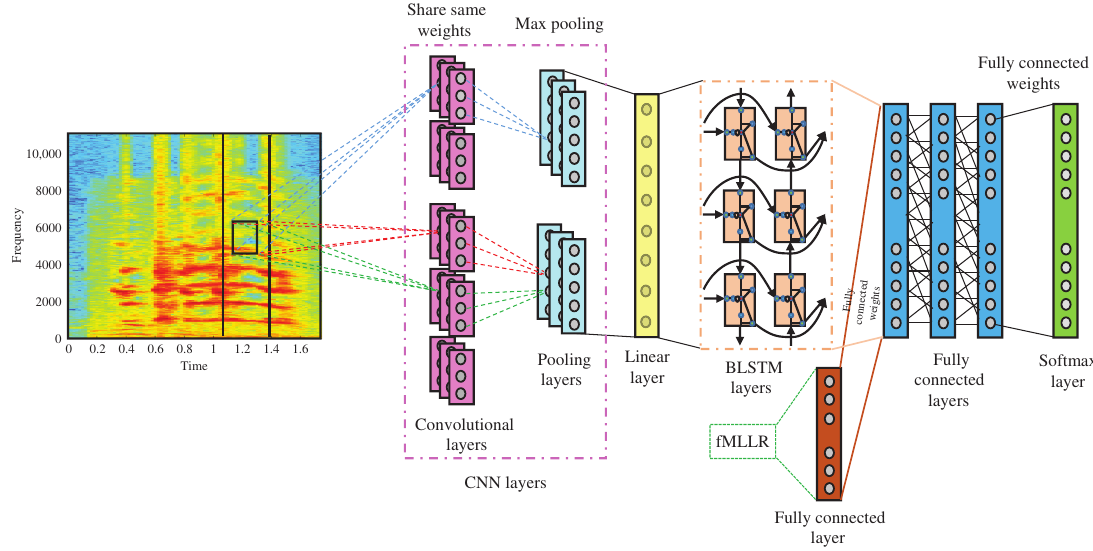
Figure 1: An Illustration of the CNN-BLSTM Architecture Applied to Log-Mel FB Features of the Speech Signal. filter. Initially, max pooling is used in our model, and pooling is applied only in the frequency domain. For both layers, the pooling size used is 2, and the value of stride is also